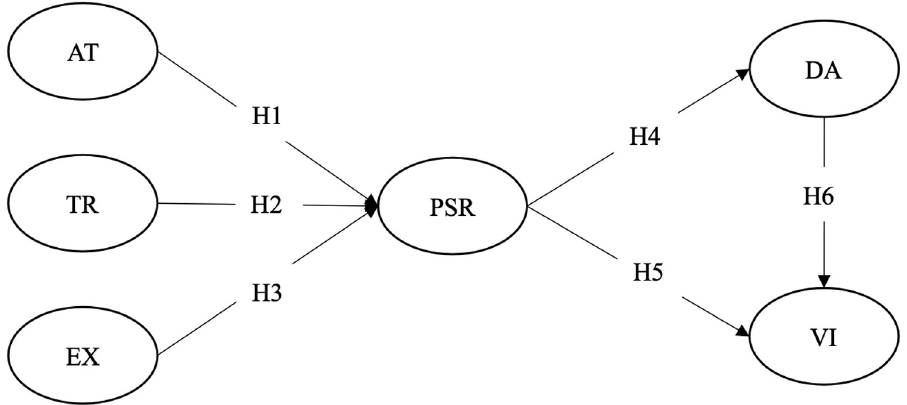
Fig 1. Proposed research